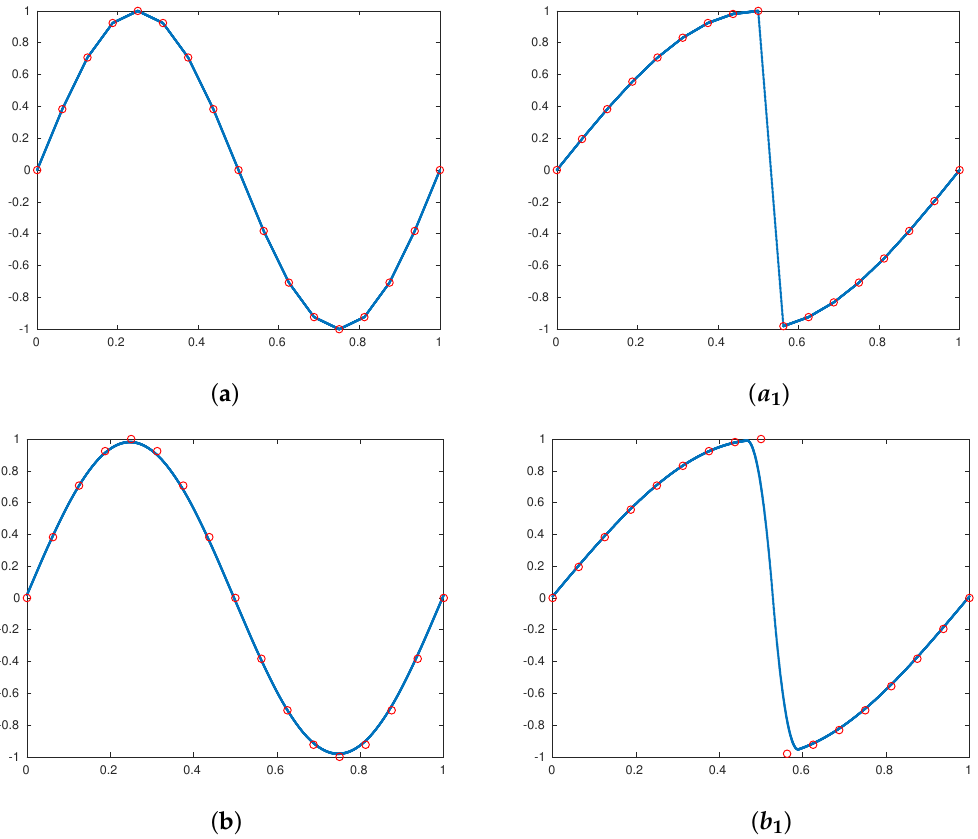
Figure 1. Images on the left were obtained using the continuous function (33), images on the right were obtained using the discontinuous function (34) using five subdivision scales; the results shown in ( a ), (also a 1 ) and ( b ), ( also b 1 ) were obtained by S 1 (10) and S 2 (11), respectively, where w = 1 In this figure, the original sampling is represented in ◦